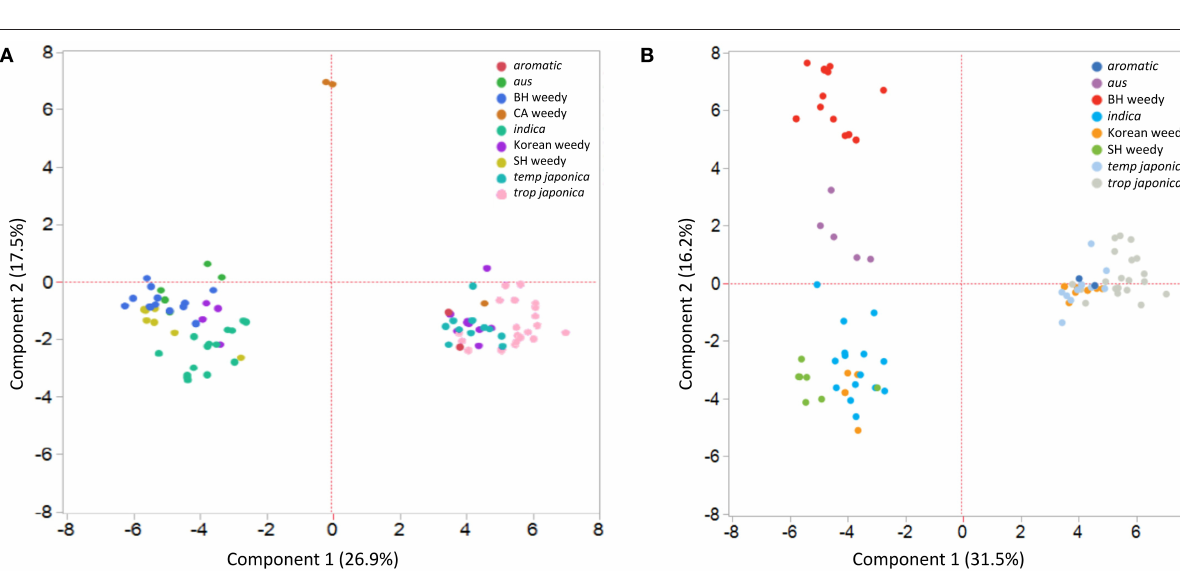
with the exception of one (IRGC #112820) contained the 22 bp causal deletion in Bh4 that is found in most cultivated rice. As